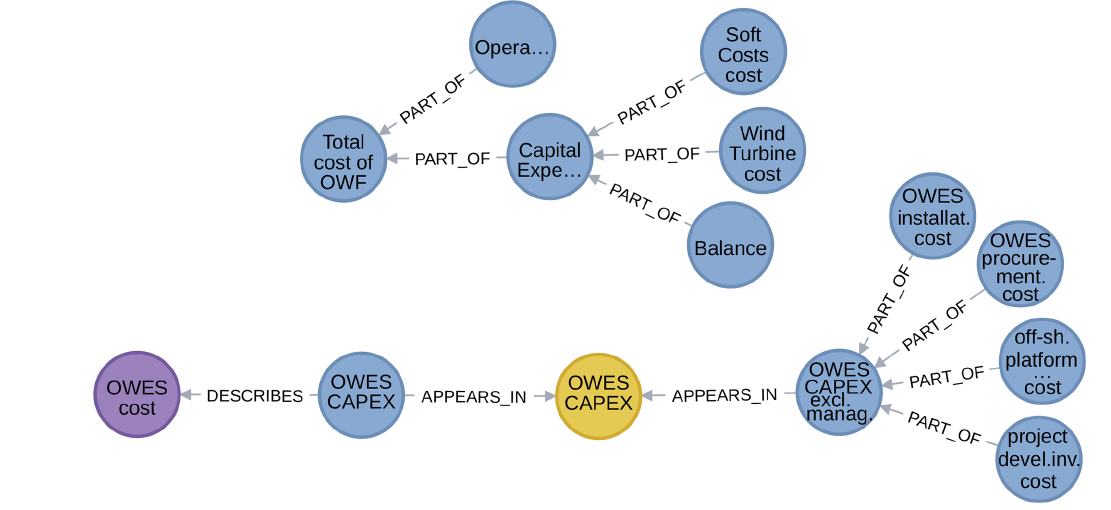
Figure 13. An example from WESgraph of concept duplication to be eliminated (CAPEX – capital